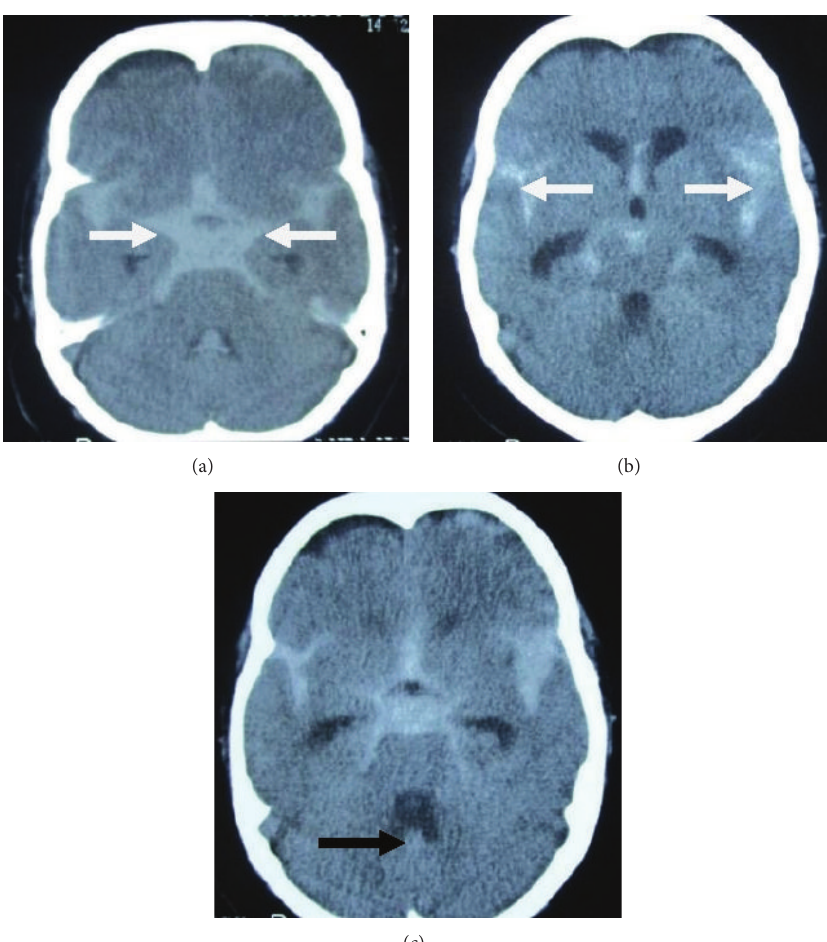
Figure 2: Second CT scan brain without contrast showing clearly visible subarachnoid bleed. (a) Classical star shaped hyperdensity seen filling the subarachnoid space most apparently around the circle of Willis (white arrows); (b) hyperattenuating signal in bilateral sylvian fissures (white arrows); (c) trickle of blood seen extending into the ventricular system (black arrow) (also visible in